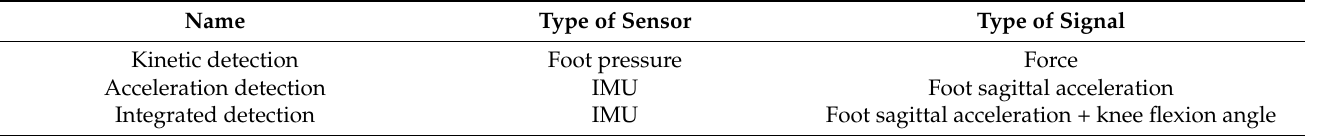
Table 3. Overview of the three analytical methods used to detect foot contact and foot-off.